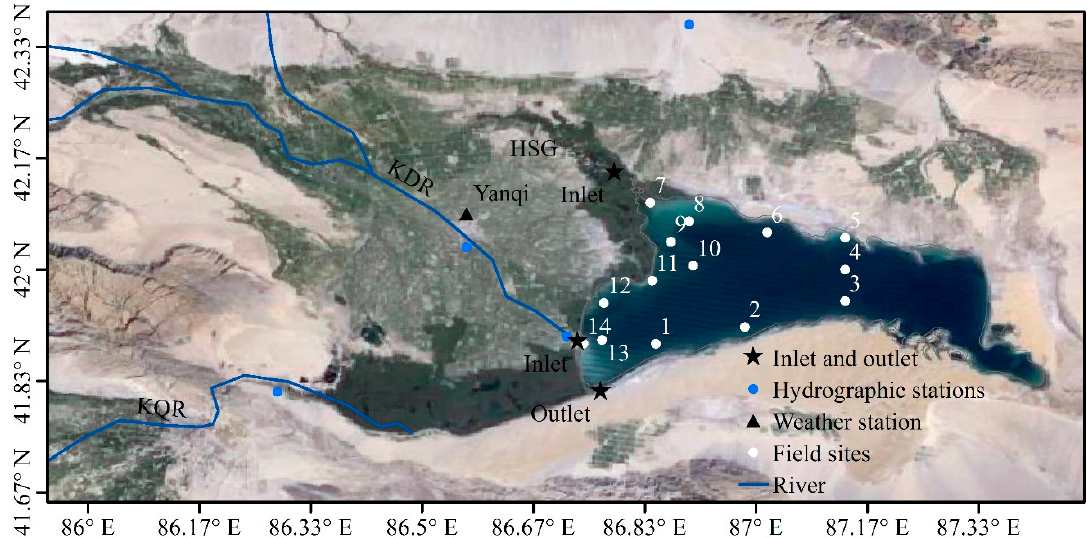
Figure 1. The surroundings (obtained from Google Earth) and topography of Bosten Lake (where white sold circles stand for the measured sites; KDR, KQR, and HSG represent Kaidu River, Kongque River, and Huangshuigou, respectively; and the black stars stand for the inlets of KDR and HSG, and the outlet to KQR).